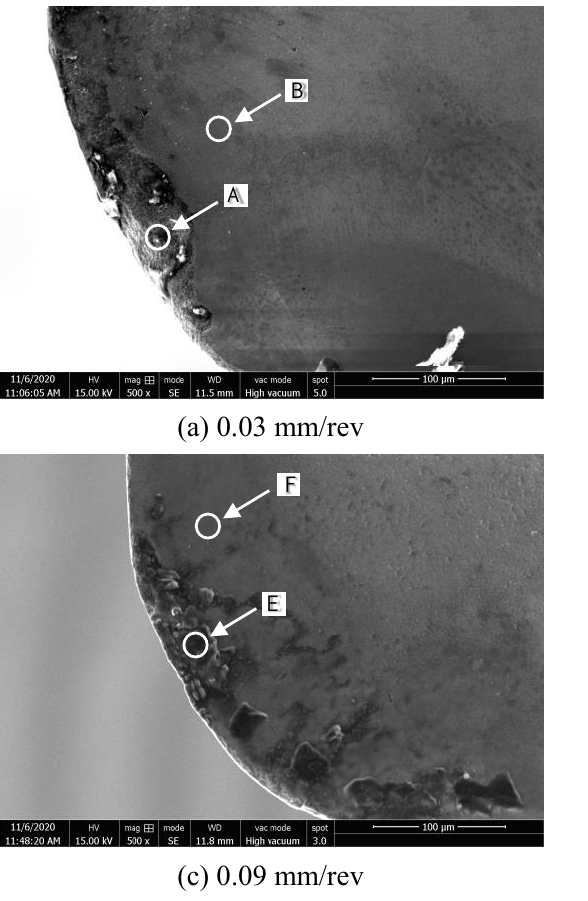
Figure 6. The wear morphology of rake face at different feed (cutting speed 900 m/min, cutting depth 0.5 mm, cutting width 3 mm). ( a ) 0.03 mm/rev; ( b ) 0.07 mm/rev; ( c ) 0.09 mm/rev; ( d ) 0.11 mm/rev.